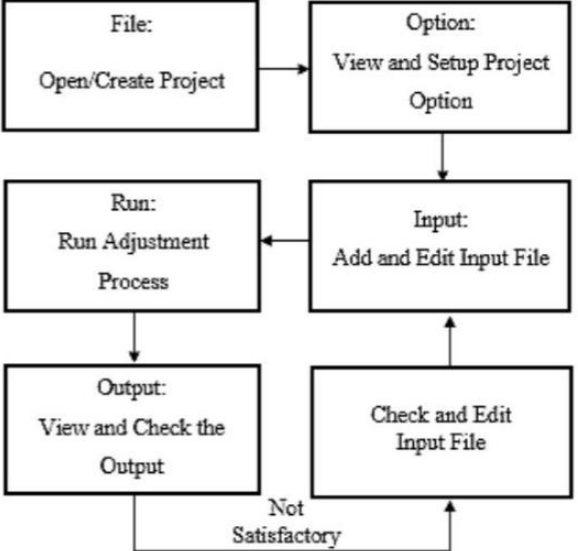
Figure 5. Processing stage in Star*net adjustment software